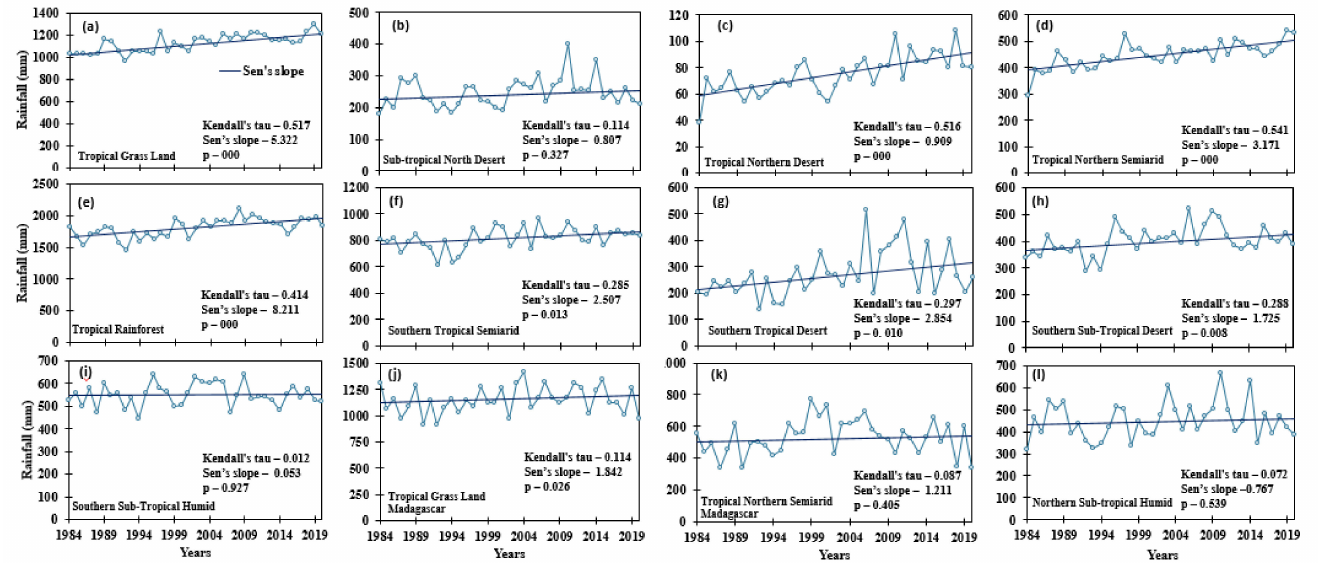
Figure 9. Annual rainfall trend for different climate zones ( a ) Tropical Grass Land, ( b ) Sub-tropical North Desert, ( c ) Tropical Northern Desert, ( d ) Tropical Northern Semi-arid, ( e ) Tropical Rainforest, ( f ) Southern Tropical Semi-arid, ( g ) Southern Tropical Desert, ( h ) Southern Sub-Tropical Desert, ( i ) Southern Sun-Tropical Humid, ( j ) Tropical Grass Land—Madagascar, ( k ) Tropical Northern Semi- arid—Madagascar and, ( l ) Northern Sub-Tropical Humid in Africa, including